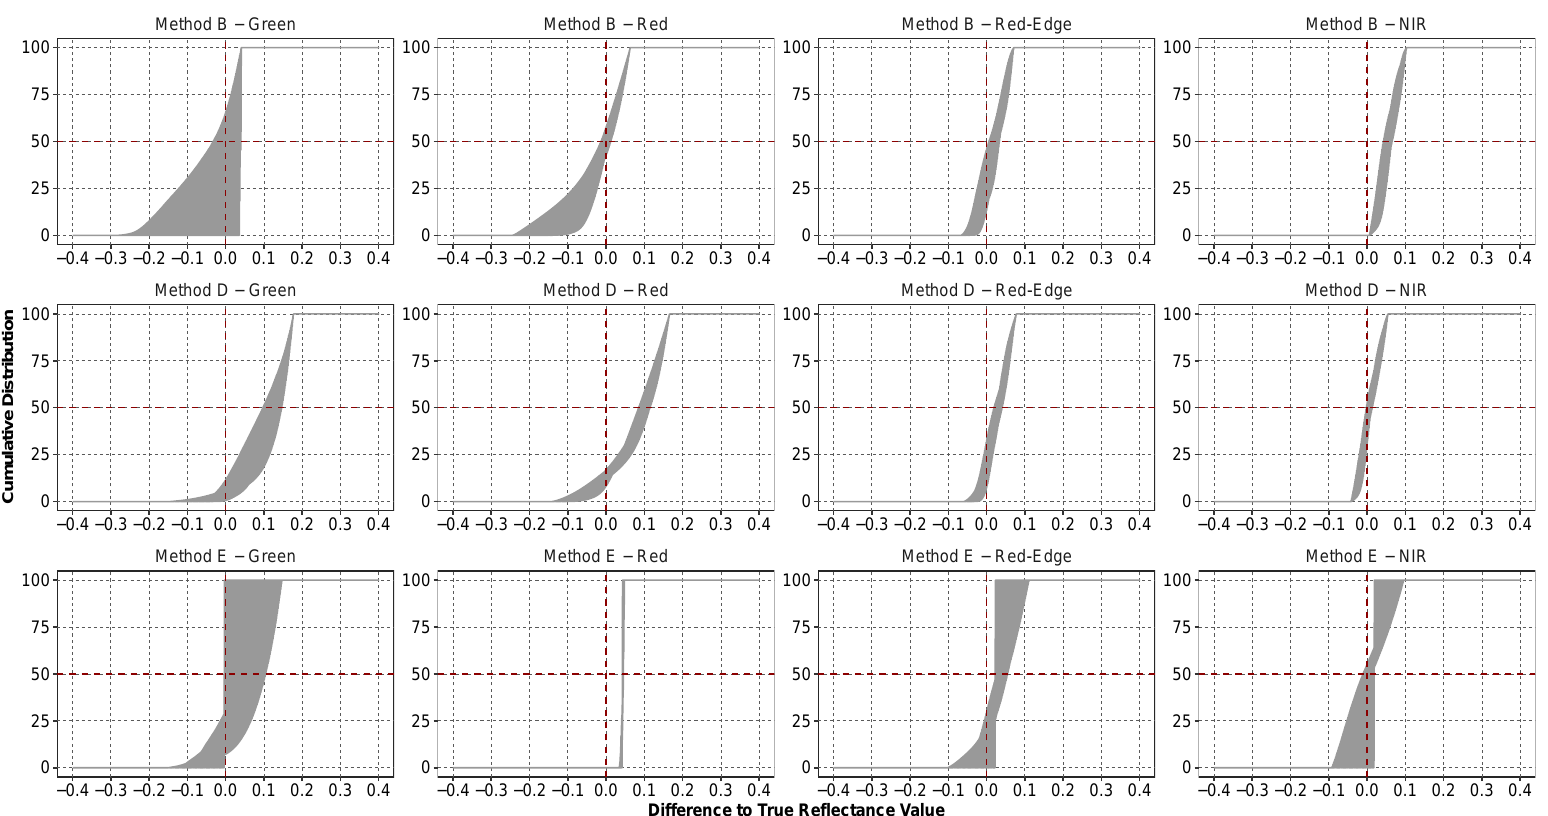
Figure 9. Radiometric error cumulative distribution for each multispectral band and radiometric calibration method. The grey areas represent the variability observed between flights for each band and calibration method. The x = 0 and y = 50% lines were added to each plot to help identify radiometric error distribution